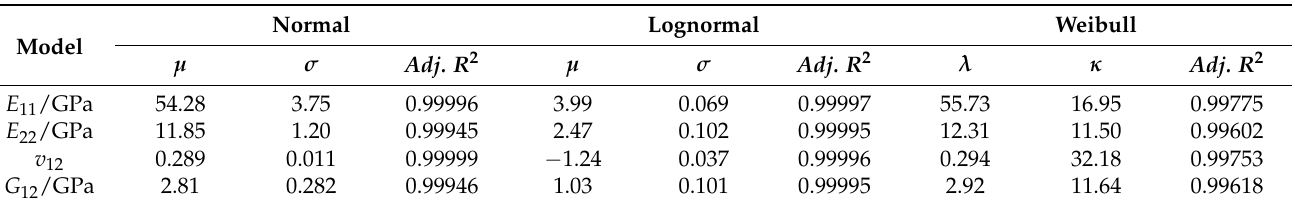
Table 18. Values of the three statistical distribution parameters for the stiffness properties of H-GFRPs under the ETW